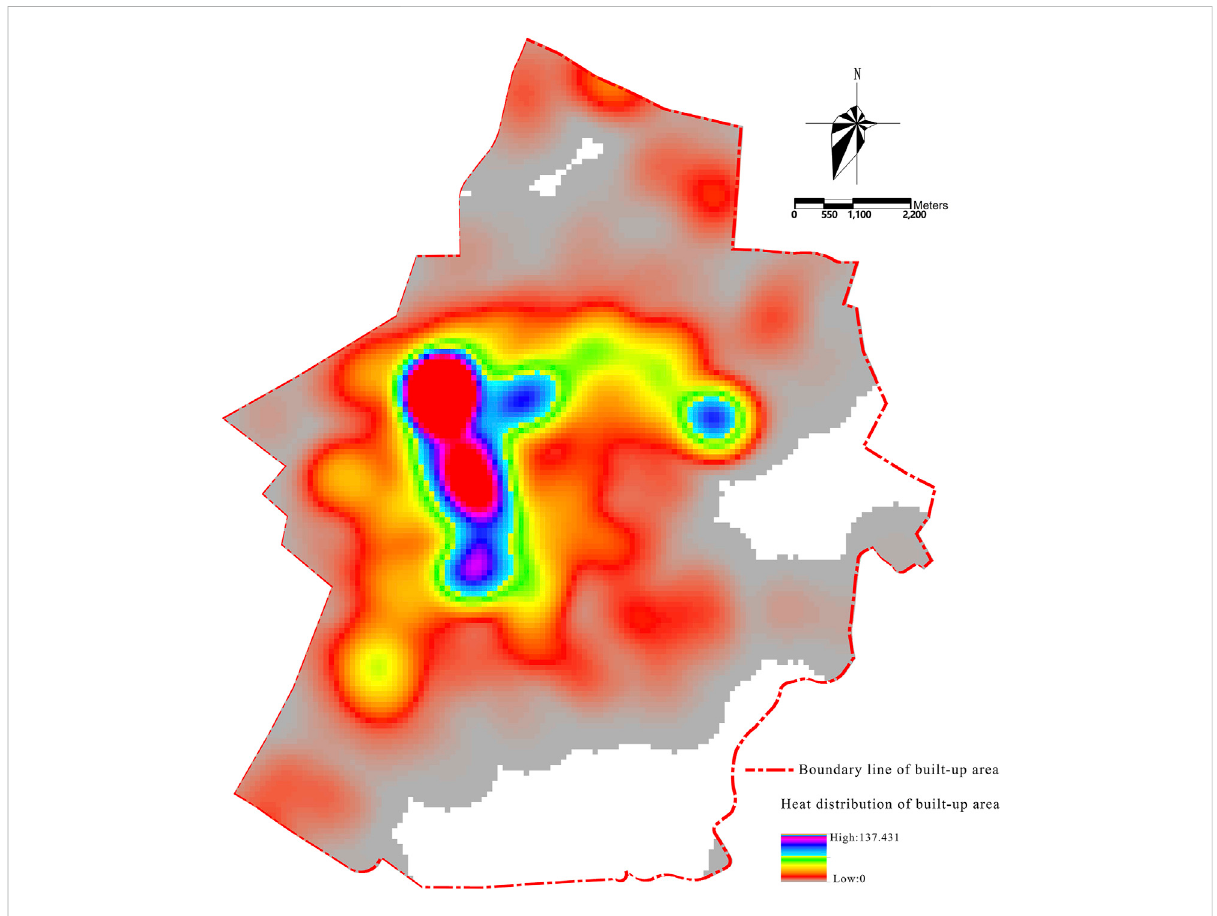
FIGURE 4 Thermal distribution of crowd activity in Yuxi City